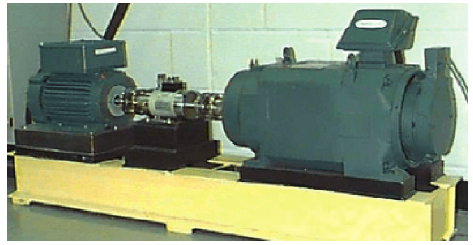
Figure 12: Test rig in Case Western Reserve University.